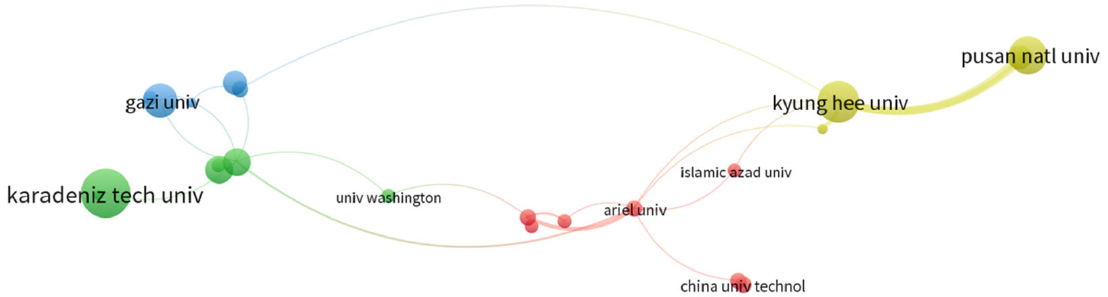
Figure 5. Co-authorship organization Figure 5. Co ‐ authorship organization networks. Figure 5. Co ‐ authorship organization networks.